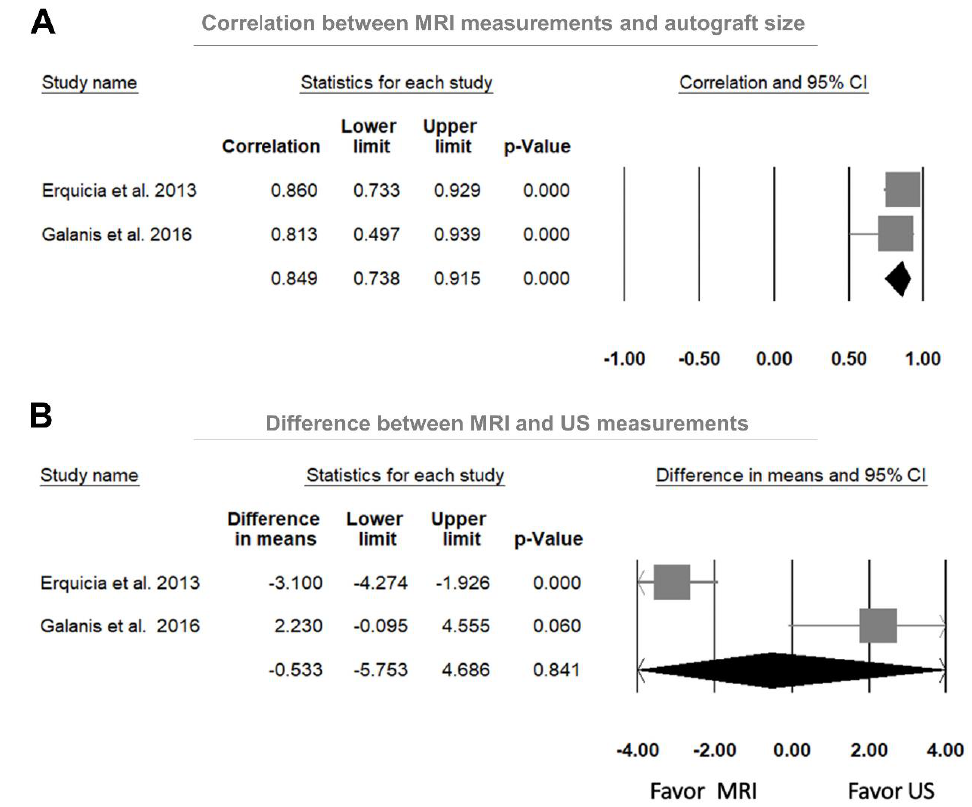
Figure 3. Forest plot of the summarized sensitivity and specificity of ultrasound imagining for predicting the autograft size inadequacy. CI, confidential interval.